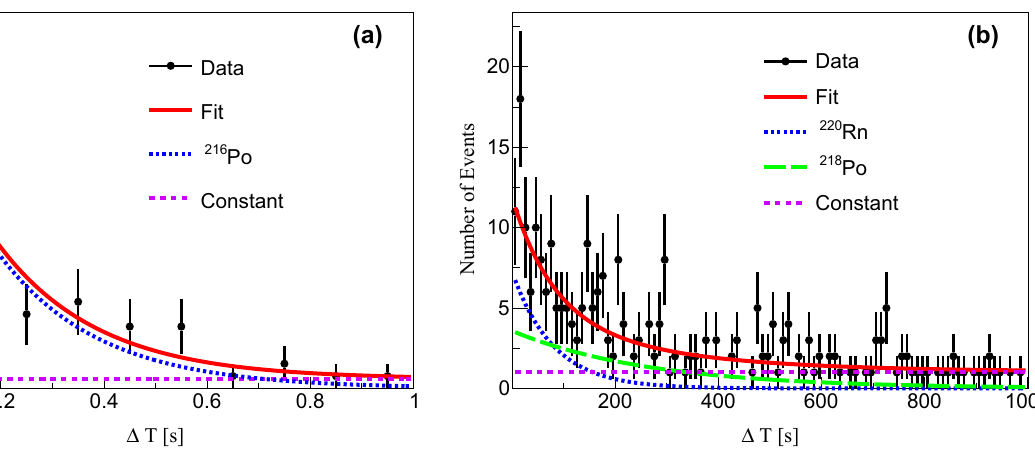
218 Po → 214 Pb(half-lifeof186s)eventsareobtainedfromtwoexponen- tial components of 218 Po (green long dashed line) and 220 Rn (half-life 55.6s), whereas the activity of 220 Rn is constrained from 216 Po mea- surement in a , together with random coincidence events (purple dashed line) in the NEO-6 crystal